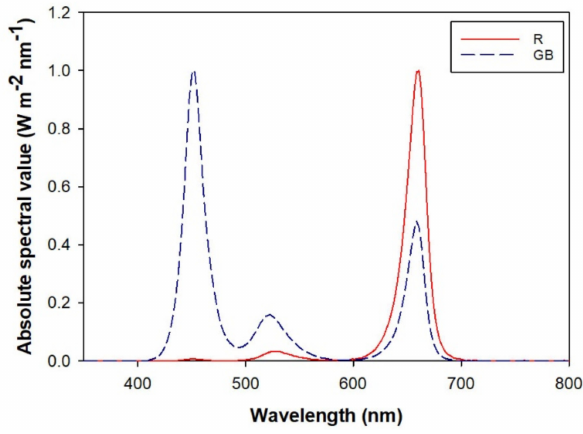
Figure 1. Spectral characteristic curves of red-light enriched (R) and green-and-blue light (GB)